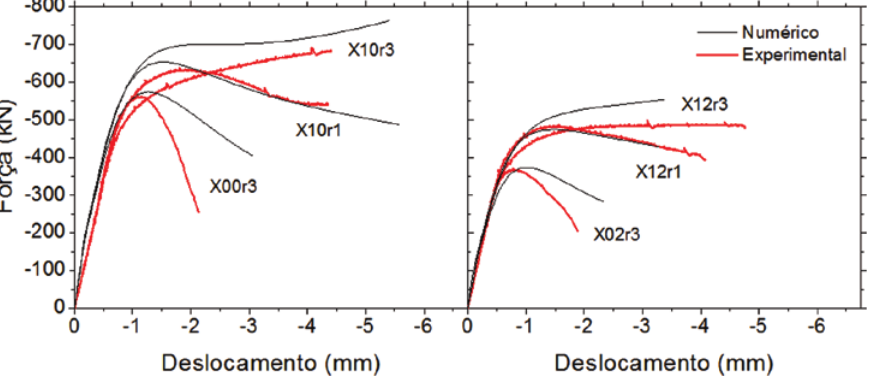
Comparação entre curvas de força versus deslocamento obtidos na modelagem numérica em relação às obtidas nos ensaios experimentais por Carrazedo [17] para pilares das série